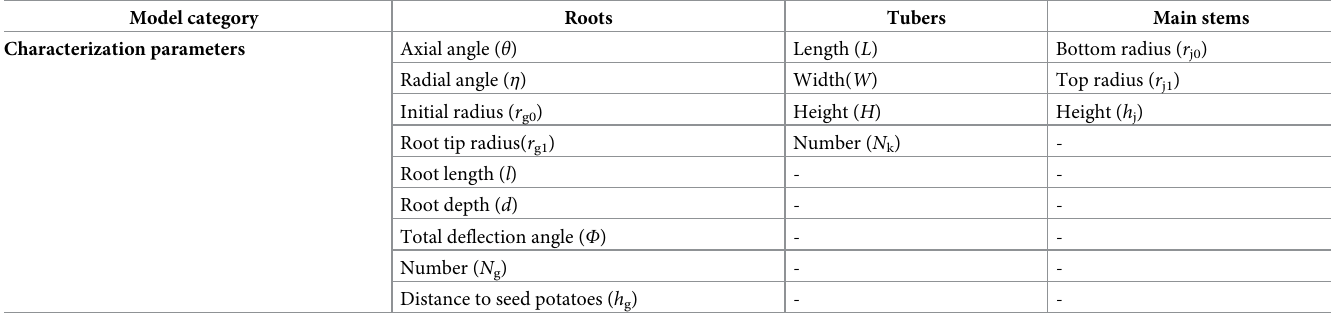
Table 1. Characterization parameters of potato tuber-root model. Model